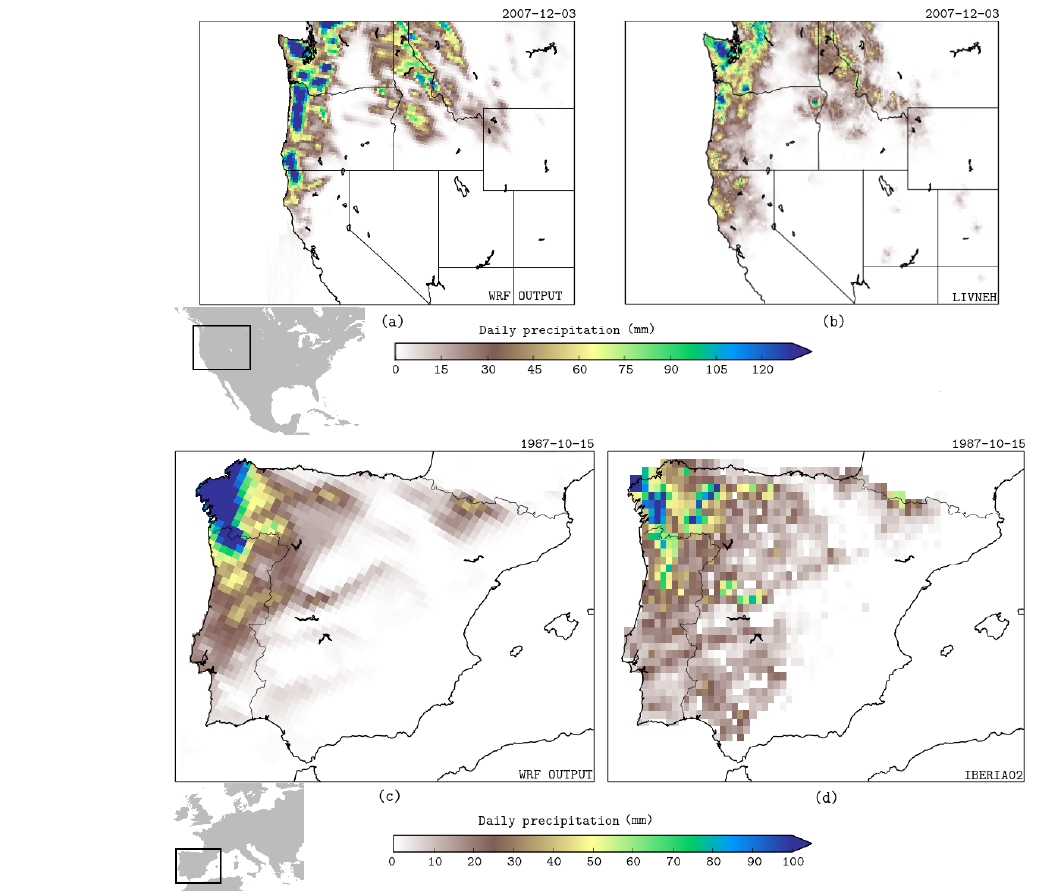
Figure 2. WRF output total precipitation for the Great Coastal Gale of 2007 (a) and the Great Storm of 1987 (c) against observations from LIVNEH (b) and IBERIA02 (d) for the same 24h